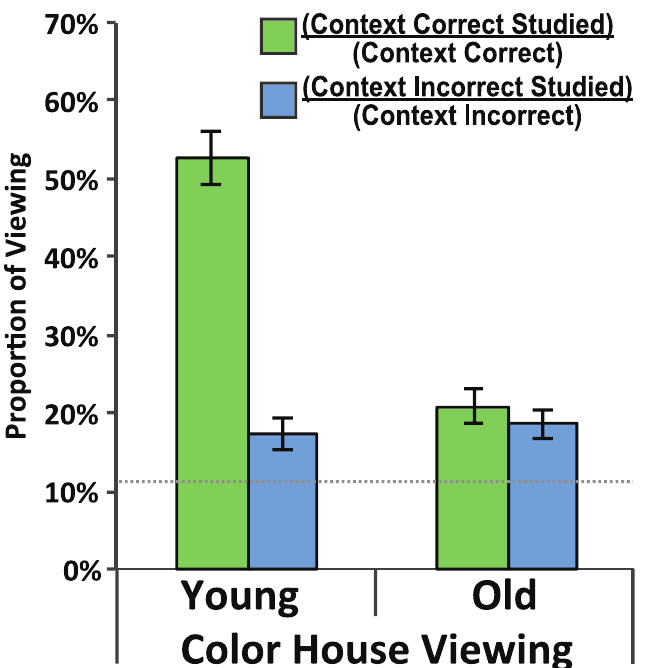
Fig 8. Studied room viewing preference. Preference for viewing of the studied room as a proportion of overall viewing to a given side of the building when the color building was presented. Green bars indicate a viewing preference for the studied room on the context-correct side of the building. Blue bars indicate a viewing preference for the studied room on the context-incorrect side of the building. Data are presented for both the Young Adult and Older Adult groups and standard error bars are shown. The dotted gray line indicates chance-level performance.